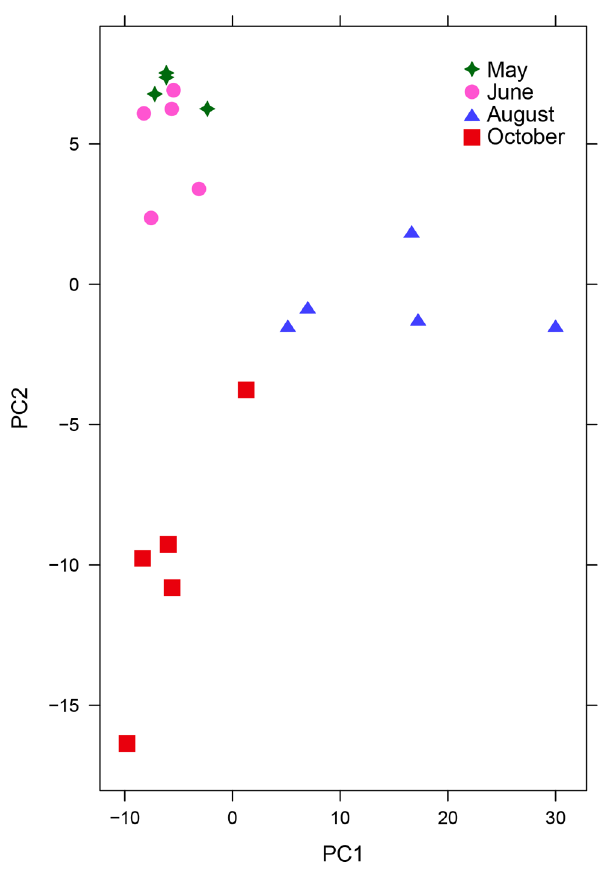
Figure 7. Seasonal variation in P.balsamifera . PCA scores plot of resin ‘fingerprints’ from individual P. balsamifera plants collected throughout the growing season. 43.99% of the total variation in the data set is shown. N=4 individuals in May, N=5 individuals in June, August, and October.